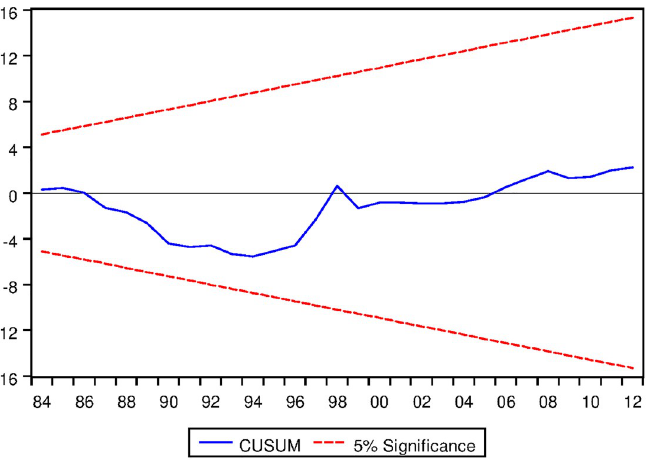
Fig 27. Stability diagnostic of cointegrating relationship for Korean data with no fixed regressor under Fisherian framework.